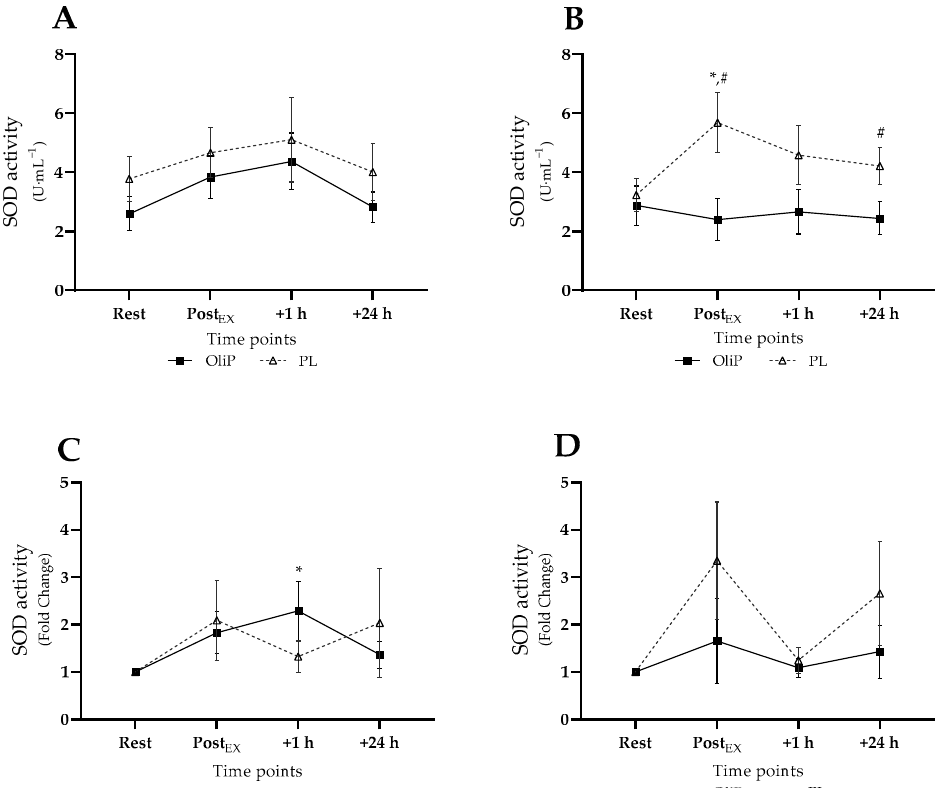
Figure 3. Plasma superoxide dismutase (SOD) activity expressed in mean absolute (U · mL − 1 ) and fold change terms in participants that were supplemented with OliPhenolia ® (OliP) for 16 consecutive days or with a matched placebo (PL). ( A , C ) Pre-intervention, before supplementation; ( B , D ) Post 16-day supplement intervention. * denotes significant difference compared to rest within condition ( p ≤ 0.038); # difference between conditions at timepoint ( p ≤ 0.046).